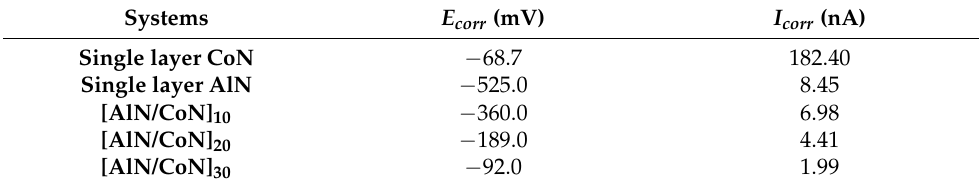
Figure 12. Tafel curves for AISI 302 steel coated with AlN and CoN single layers and [AlN/CoN]n multilayer systems. Table 4. Results calculated from Tafel polarization